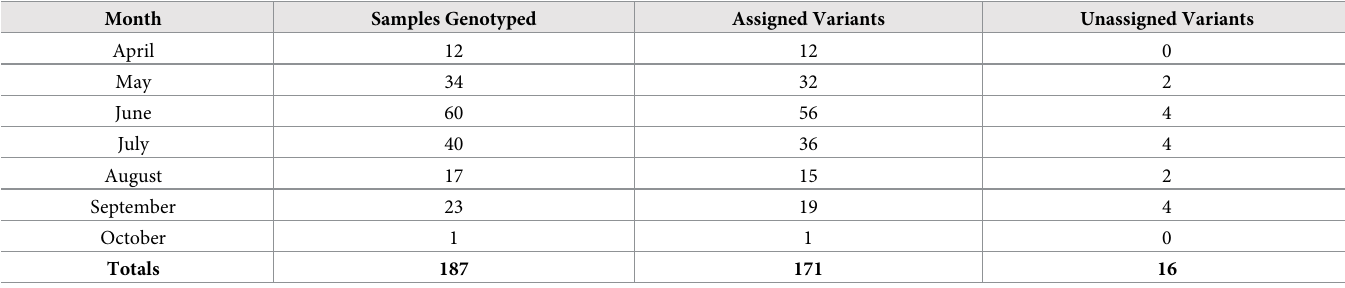
Table 3. Number of samples genotyped per month and amount of samples successfully